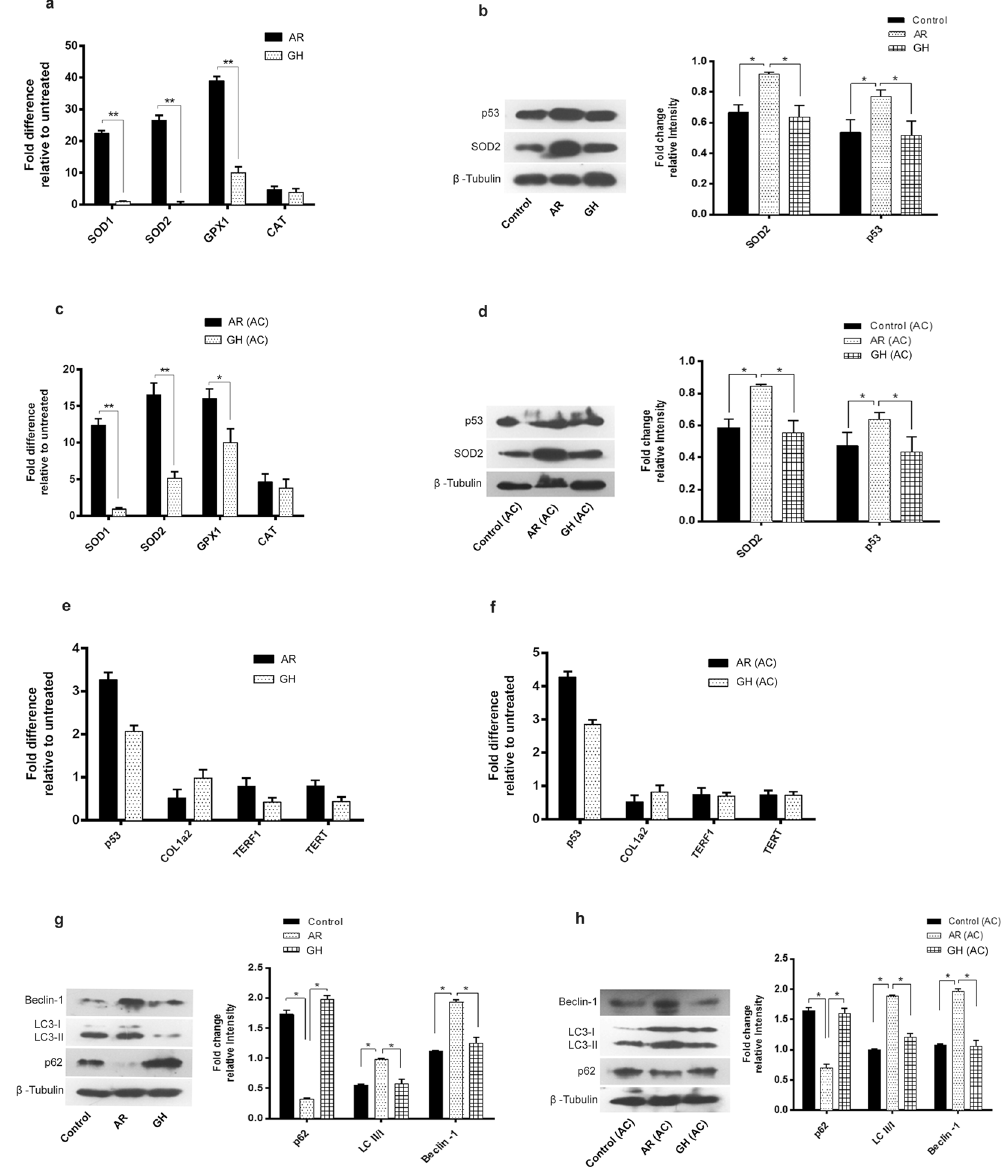
Figure 5. AR increased antioxidant defense and autophagy in both aging and AC group of rats. ( a , c ) SOD1 or 2, GPX1 and CAT mRNA expression were assessed by quantitative real-time reverse transcription-polymerase chain reaction and found a significant increase in the expression of these genes in AR administered rats. ( b , d ) Representative immunoblots of SOD2, p53 and β -tubulin from rat hearts and densitometry analysis revealed that SOD2 and p53 proteins were increased in AR administered rats. ( e , f ) p53, Col1a2, TERF1 and TERT mRNA expression were assessed by quantitative real-time reverse transcription-polymerase chain reaction. There was no significant difference in expression of these genes among the AR treated or untreated groups. ( g , h ) Representative immunoblots of Beclin-1, LC3-I/II, p62 and β -tubulin. β -tubulin was used as loading control. Values represent the mean ± s.e.m. of data from 4 rats in each group. * P < 0.05, ** P < 0.01 (AR versus GH or control groups; AR (AC) versus GH (AC) or control (AC), results were analyzed by 2-way ANOVA followed by multiple comparisons with Tukey’s